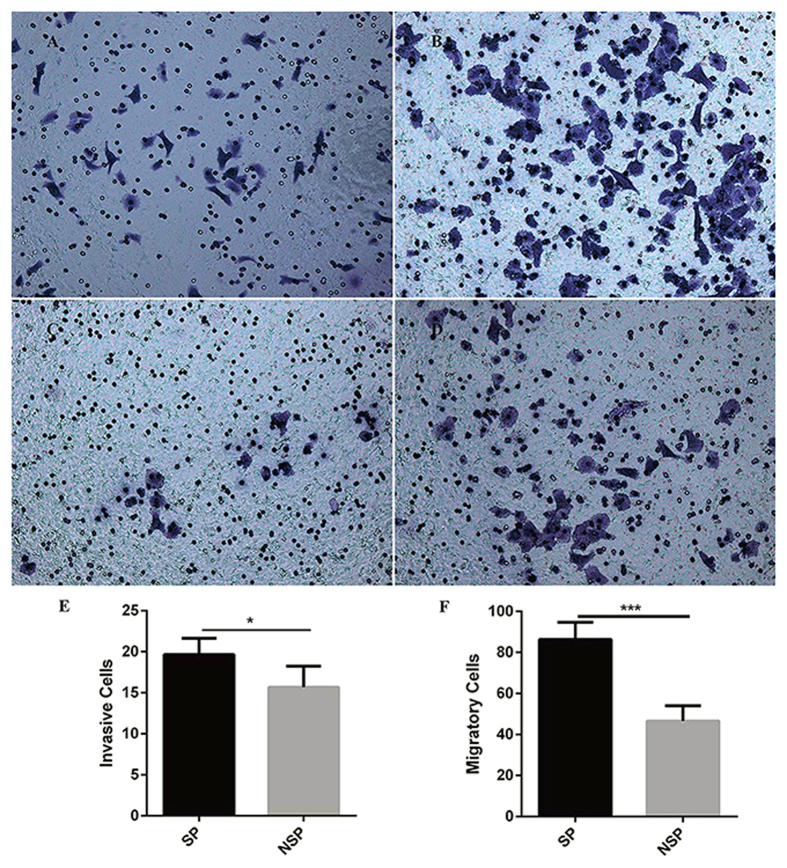
In vitro transwell cell invasion assay and in vitro transwell cell migration assay.SP and NSP cells sorted from freshly isolated HCC tissues were used for in vitro transwell cell invasion and cell migration assays. In vitro transwell cell invasion assay showed that SP cells (A) invaded more than NSP cells (C) with statistically significance (E) 19.67 ± 1.97 vs. 15.67 ± 2.58, F = 0.28, P < 0.05, n = 6). In vitro transwell cell migration assay showed that SP cells (B) migrated significantly more than NSP cells (D) with statistically significance (F) 86.33 ± 8.36 vs. 46.50 ± 7.58, F = 0.13, P < 0.05, n = 6).